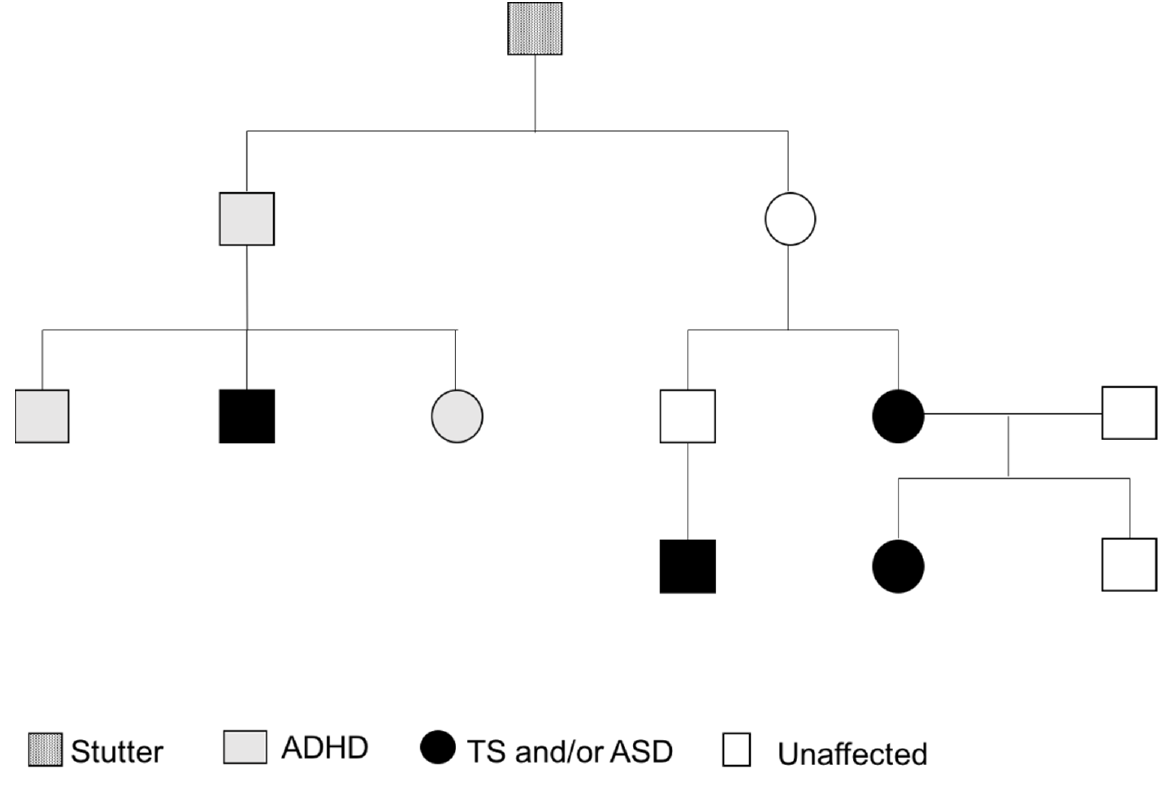
Figure 2. Family Pedigree.